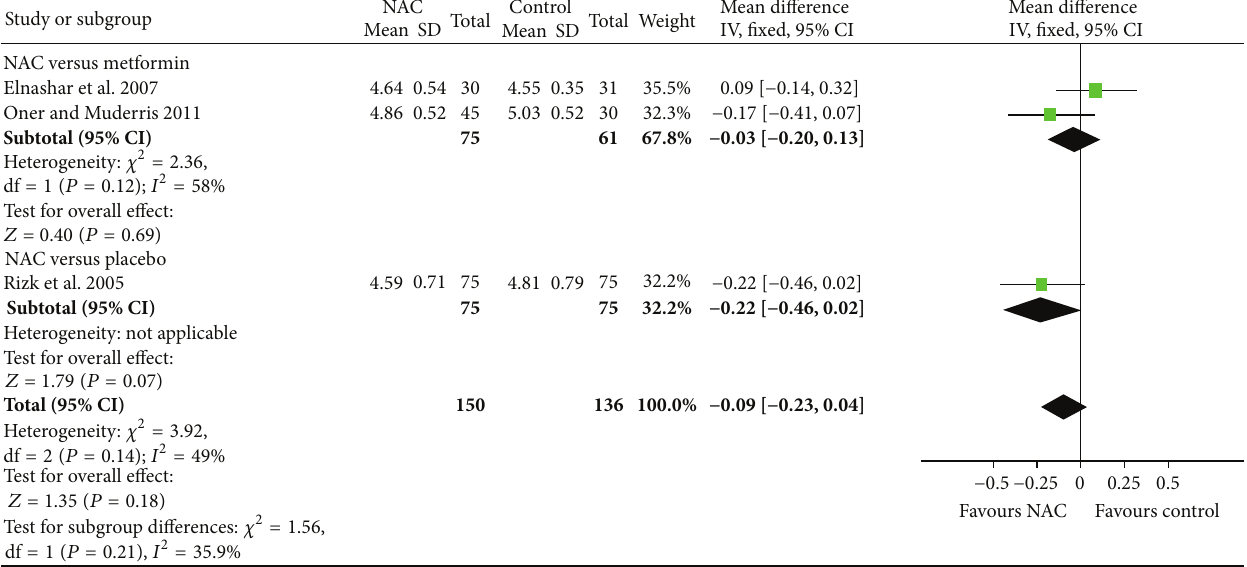
Figure 9: Forest plot: outcome: fasting glucose (mg/dL) in women with PCOS comparing NAC with